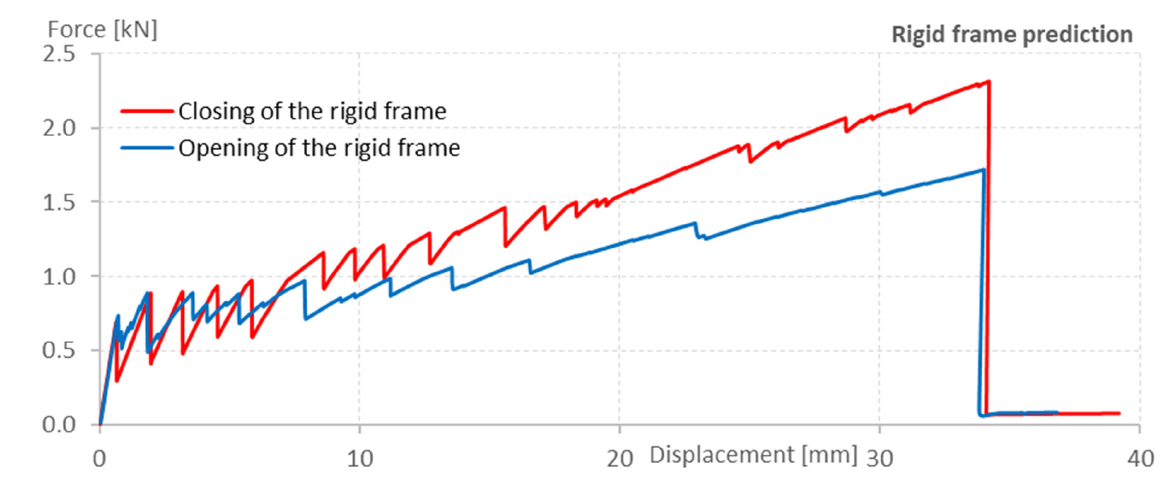
Figure 7. Numerical analysis prediction of the closing and opening of the rigid frames.